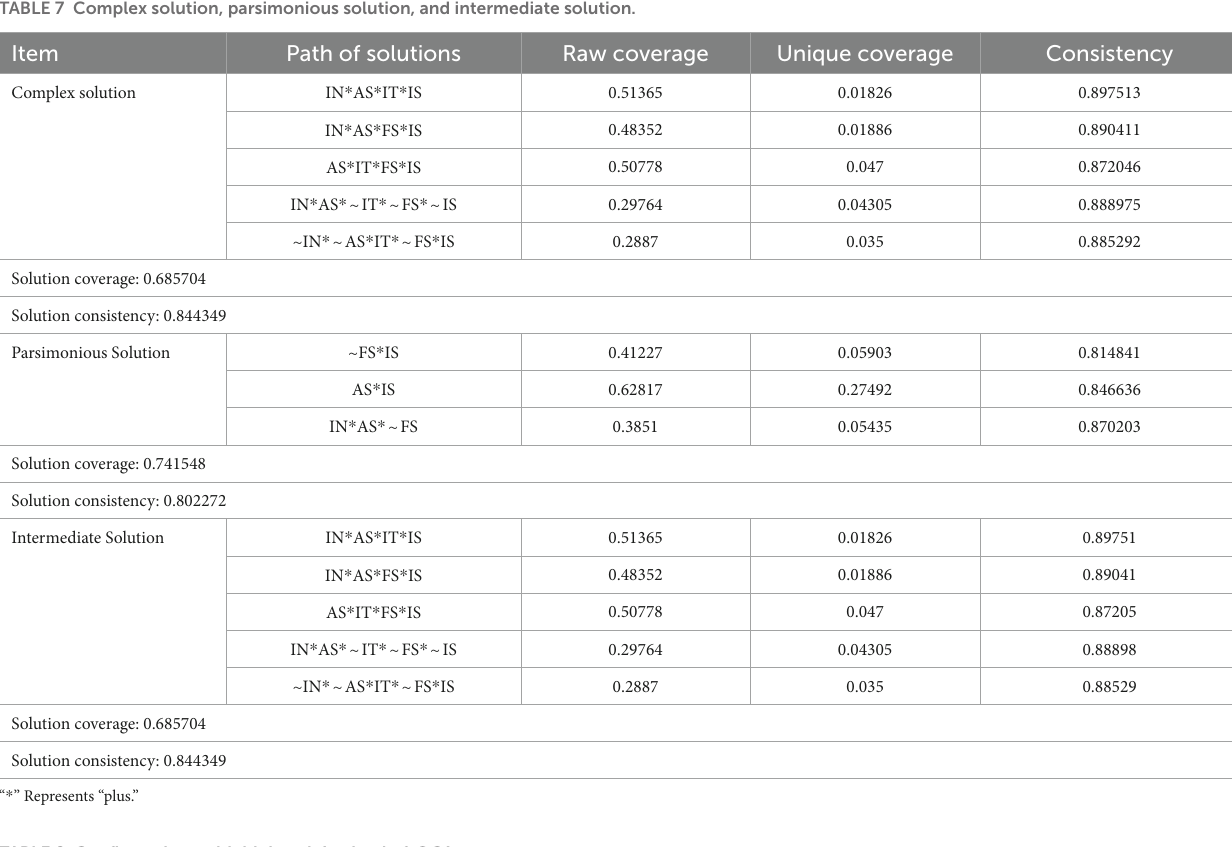
TABLE 8 Configurations with high satisfaction in